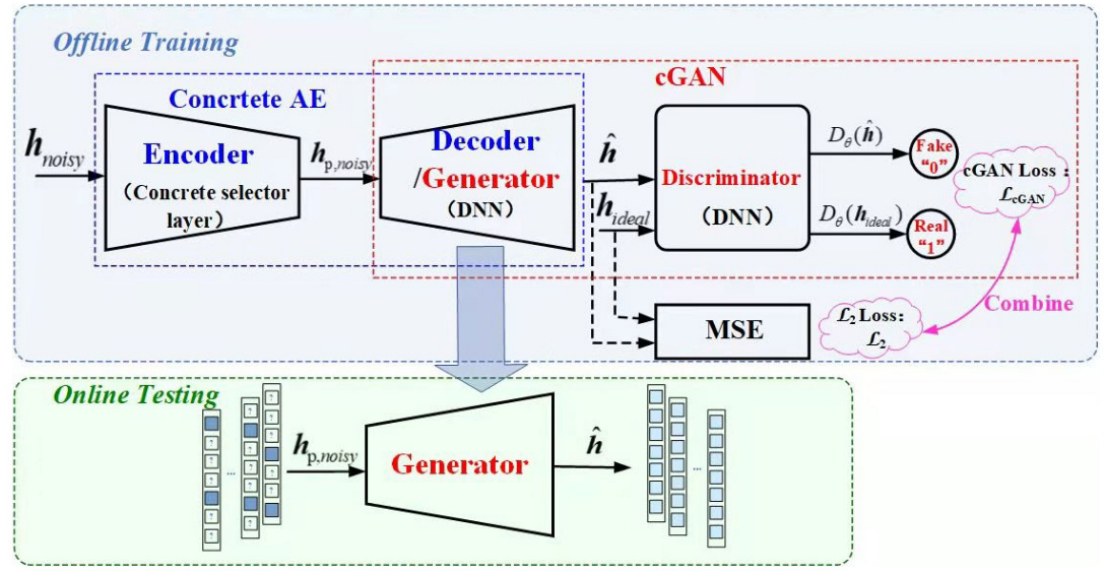
Figure 1. Architecture of the proposed CAGAN